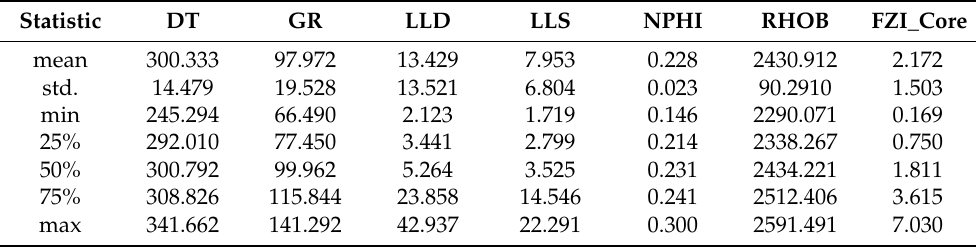
Table 3. The statistic of the 6 logs (DT, GR, NPHI, RHOB, LLD, LLS,) and FZI core data after removing